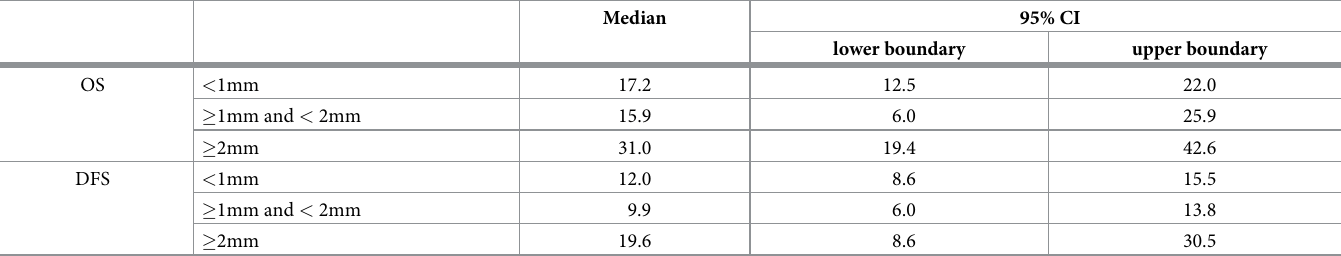
Table 2. Overall survival (OS) and disease-free survival (DFS) irrespective of positive margin site as a function of margin distance.